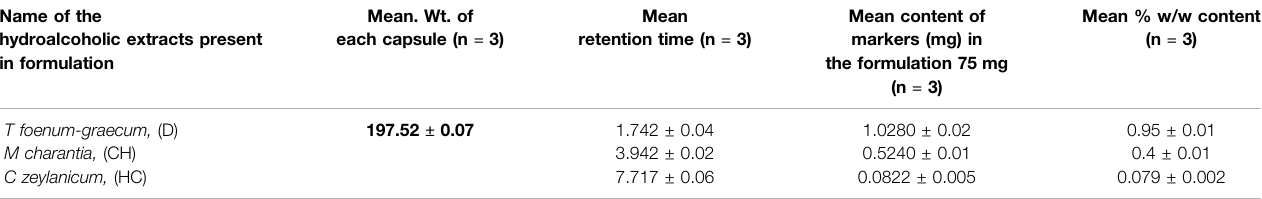
TABLE 4 | Contents of diosgenin, charantin, and hydroxychalcone in polyherbal formulation determined using the optimized HPTLC method. Name of the hydroalcoholic extracts present in formulation